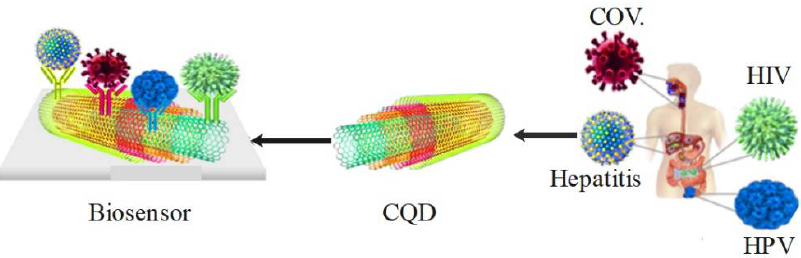
Figure 6. QD carbon nanotubes detect pandemic viruses.